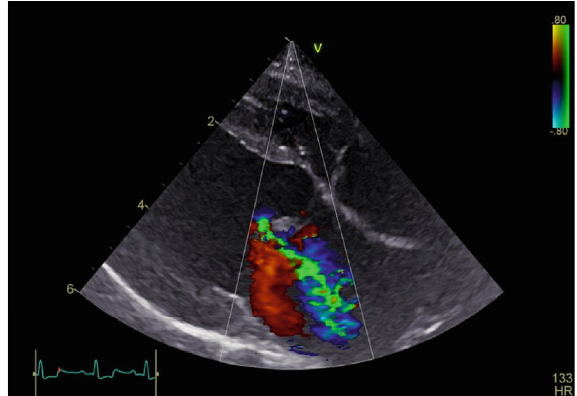
Figure 1: Color- fl ow Doppler echocardiogram obtained in the right parasternal long-axis view during systole. Mitral valve regurgitation is visible.